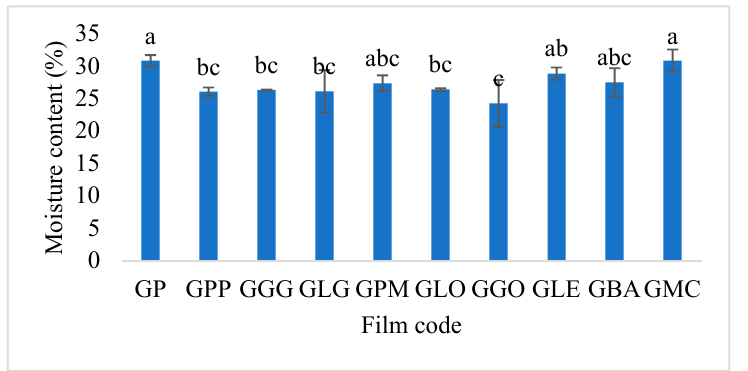
Figure 2. Moisture content of studied edible films incorporating essential oils and plant extracts. Data are means ± standard deviations. Data of each column not sharing similar letters are significantly different, at p < 0.05.